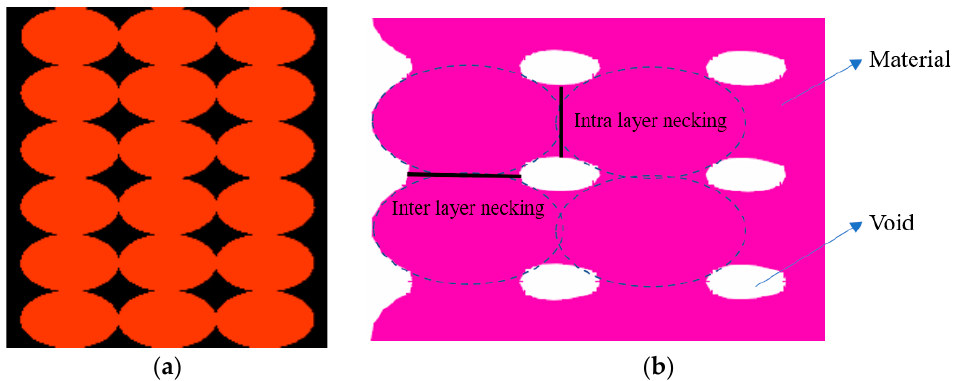
Figure 8. Representation of the filament: ( a ) initial geometry; ( b ) adjusted to represent the intra and inter layer necking.